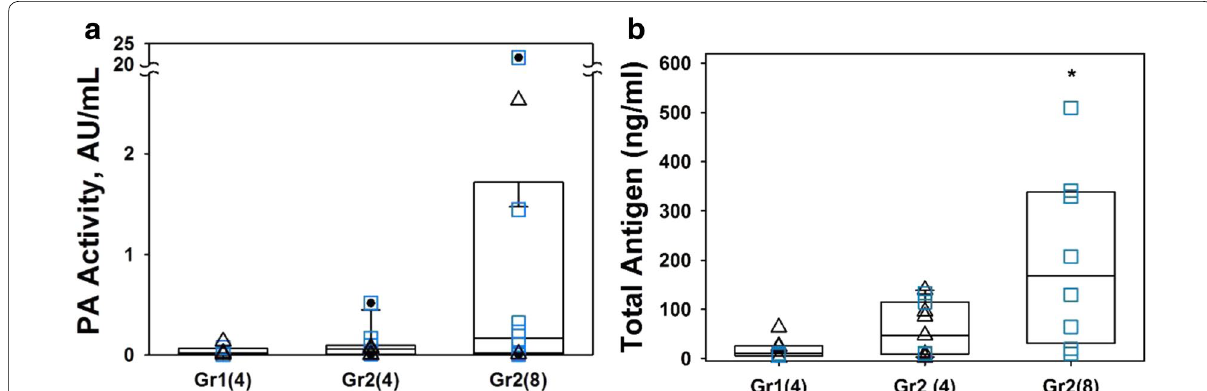
Fig. 5 SCMV ventilation with limited suctioning and increased in a dose of plasminogen activator improved BAL PA delivery. a , b Changes in the ventilation strategy Group 2 (Gr2) vs Group 1 (Gr1) and an increase in the dose of the tPA (triangles) or scuPA (squares) from 4 to 8 mg resulted in an increase in BAL plasminogen activator (PA); human uPA or tPA activity ( a ) and antigen ( b ) after 48 h of treatment. Data are presented as box plots (showing interquartile ranges). Total antigen increases significantly (p < 0.001) overall as ventilation strategy changes from Gr1 at 4 mg through Gr2 at 4 mg to Gr2 at 8 mg. Pair-wise, the differences in median was profound only between Gr1 at 4 mg and Gr2 at 8 mg (p significant difference in the median of these parameters were noted between Gr1 and Gr2 at 4 mg. There was no statistically significant difference between levels of PA activity between the groups